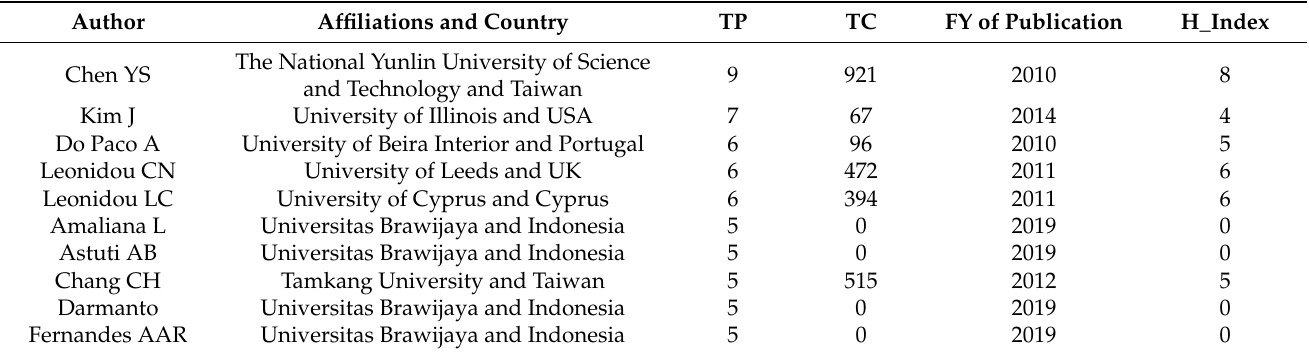
Table 3. Authors